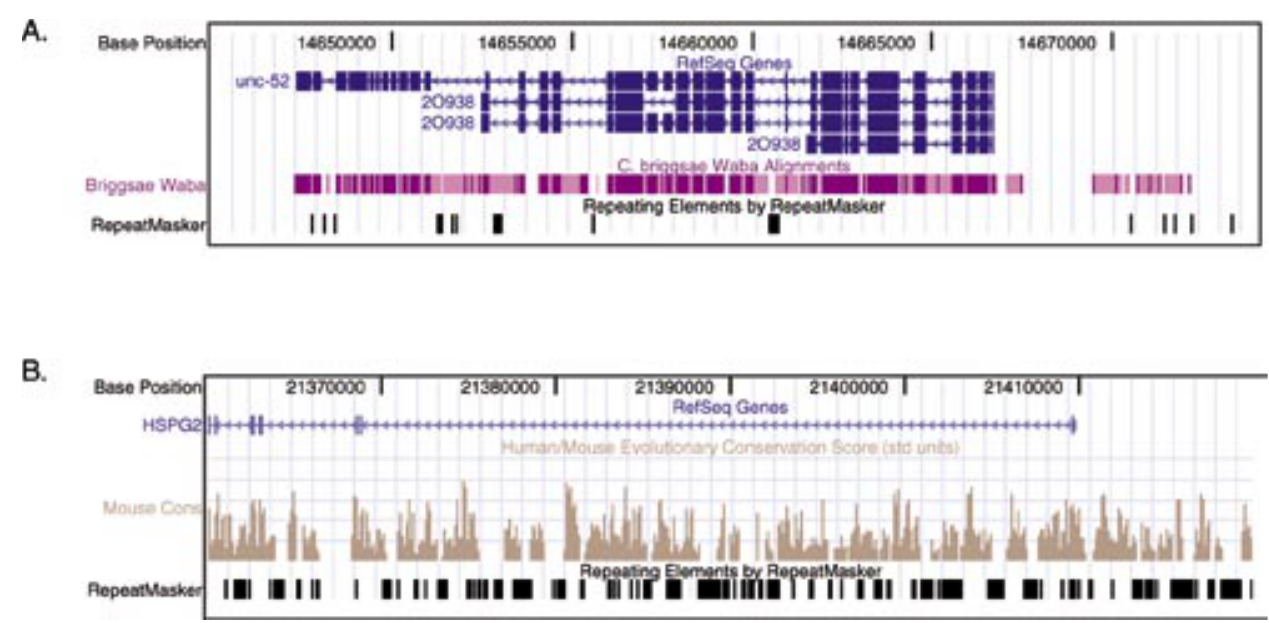
DOI: 10.1371/journal.pbio.0000058.g002 Figure 2. Examples of UCSC Genome Browser Views of Genes and Alignments The unc-52 gene in C. elegans (A) and part of its homolog HSPG2 in human (B) are shown, with rectangles for exons and lines for introns; arrows along the introns show the direction of transcription. Both genes encode a chondroitin sulfate proteoglycan. The gene in C. elegans is much smaller (about 29 kb) than the gene in humans (about 180 kb; only the 5’ portion is shown in [B]). The positions of alignments between C. elegans and C. briggsae are shown by the purple rectangles in (A). The probability that alignments between human and mouse result from purifying selection are plotted along the Human Cons track in (B). Note that in both comparisons, substantial amounts of intronic and flanking regions align, and several peaks of likely-selected DNA are seen for the human-mouse alignments in the noncoding regions. Among these are candidates for regulatory